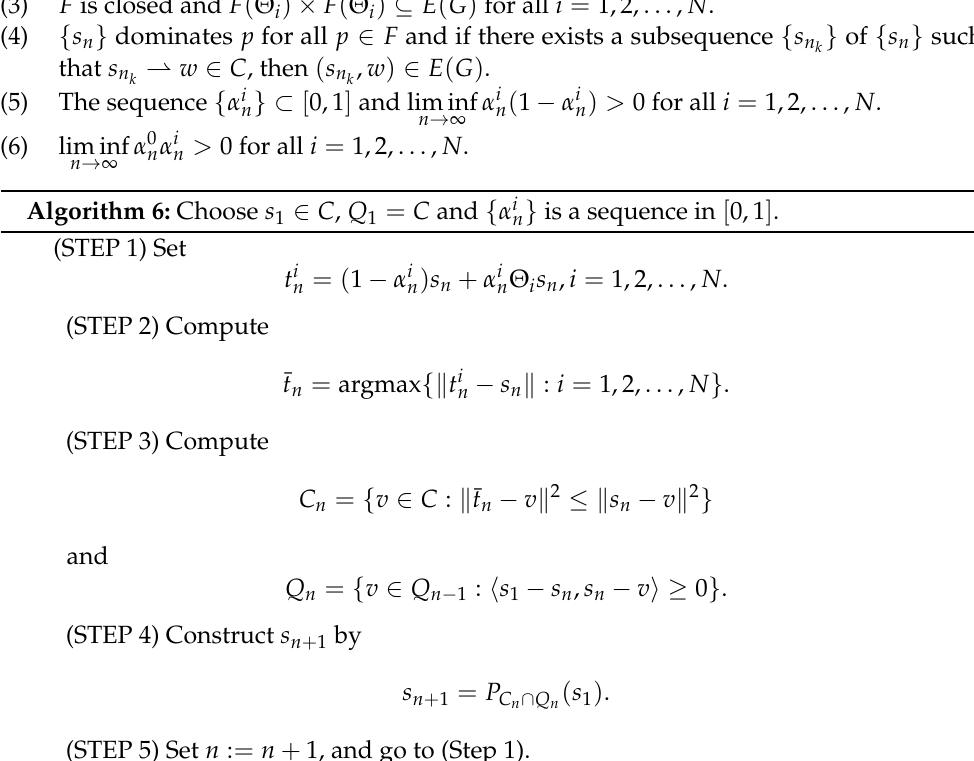
} is a sequence in [ 0, 1 ] n